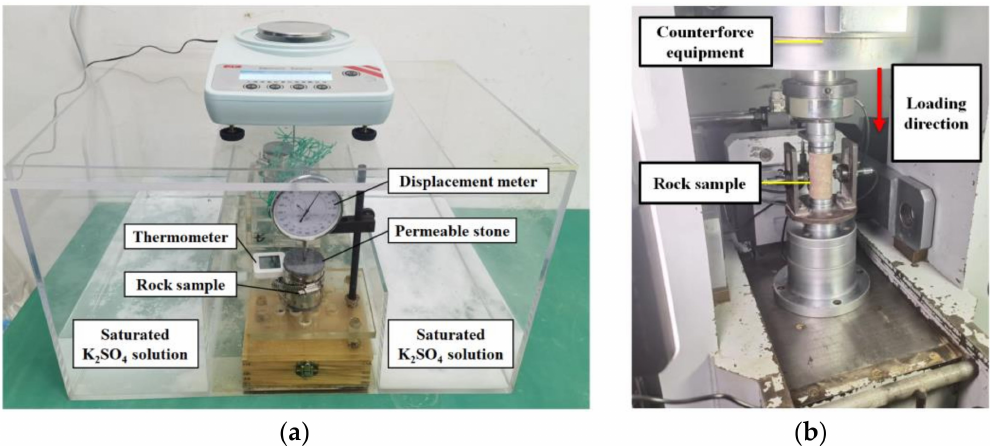
Figure 3. Test device: ( a ) The swelling test; ( b ) The uniaxial compression